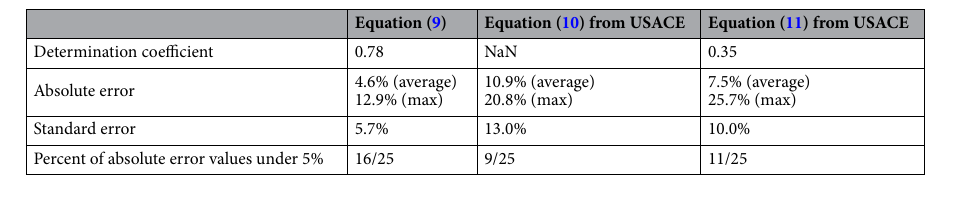
Table 3. Comparison of the TDG estimation